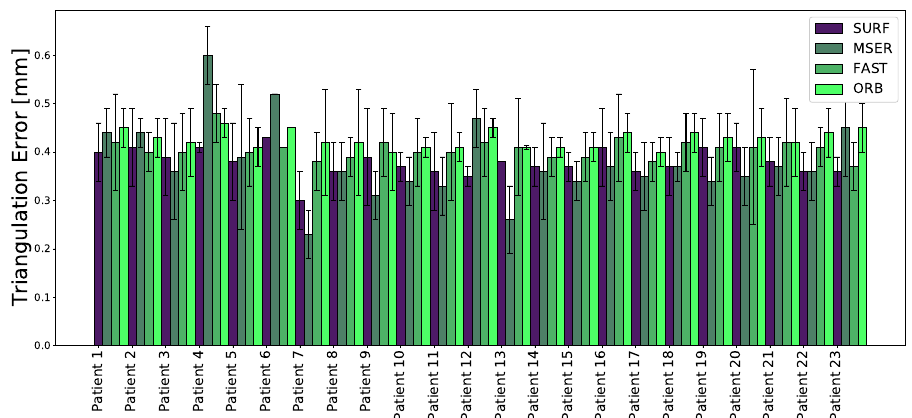
Figure 9. Mean 3D triangulation error and standard deviation for different local feature descriptors calculated per patient.